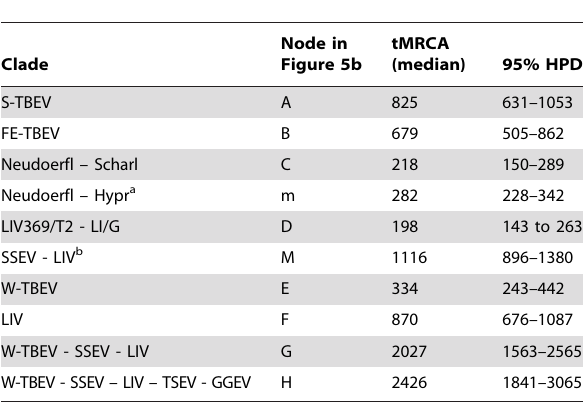
Table 4. Times of origin (in years before 2008) for selected clades in the phylogenetic tree of Tick-borne encephalitis virus , obtained from the BEAST inference 4 based on a large E- sequences